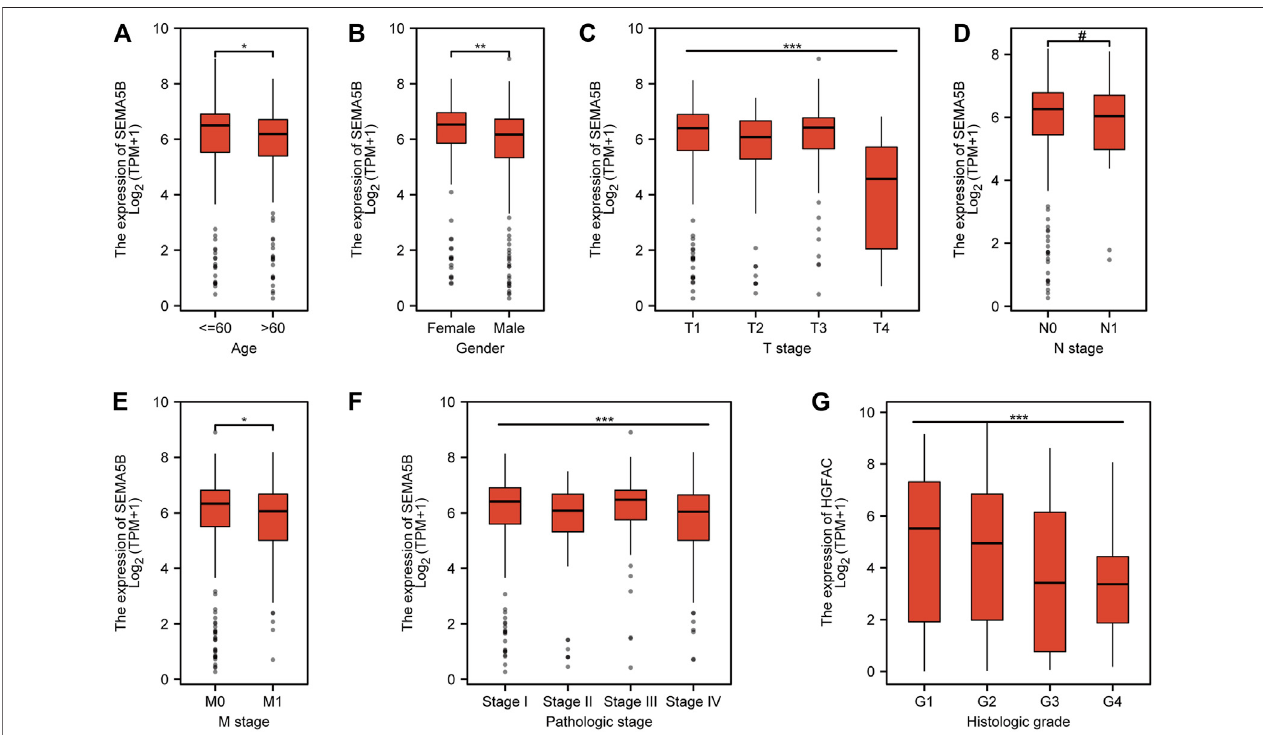
FIGURE 2 | Associations of SEMA5B expression with clinical parameters. (A) Age ( p < 0.05); (B) Gender ( p < 0.01); (C) Tstage ( p < 0.001); (D) N stage ( p < 0.05); (E) M stage ( p < 0.05); (F) Pathologic stage ( p < 0.001); and (G) histologic grade ( p <